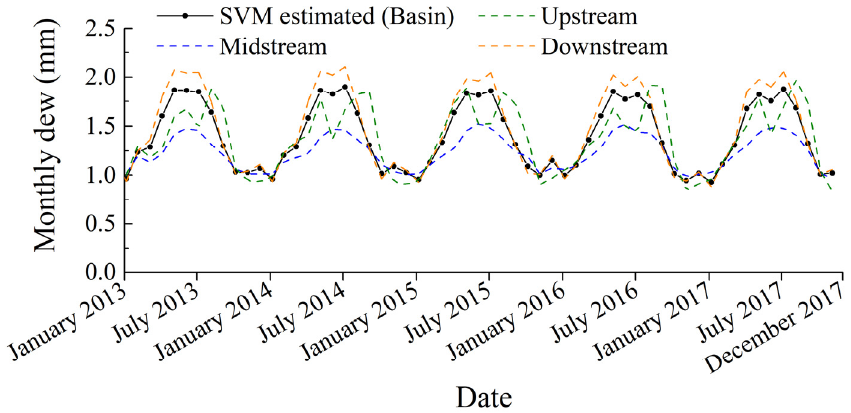
Figure 8. Basin-scale monthly dew yields estimated using SVM.